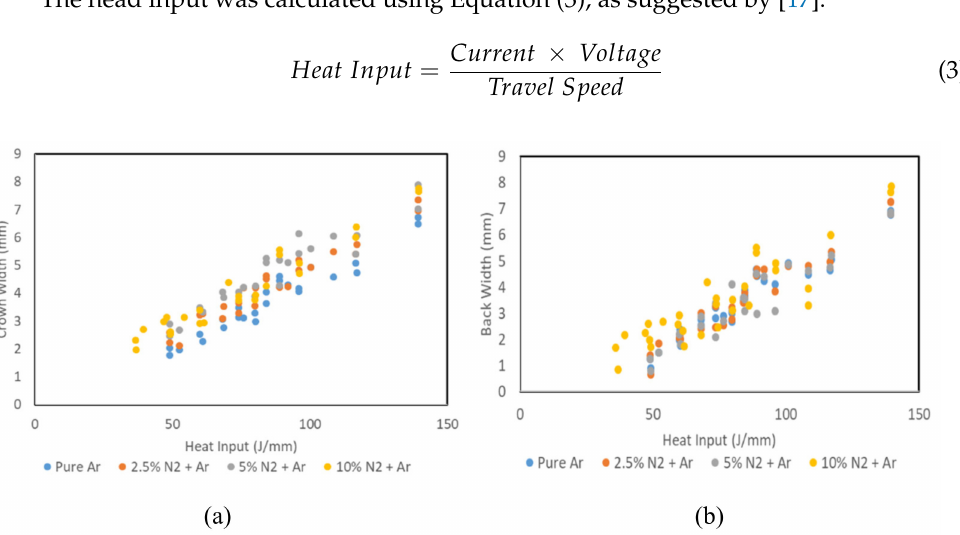
Figure 7. Comparison of ( a ) CW and ( b ) BW for welds made homogenously using pure Ar and different values of N 2 as the shielding gas on 0.7 mm thick sheets.